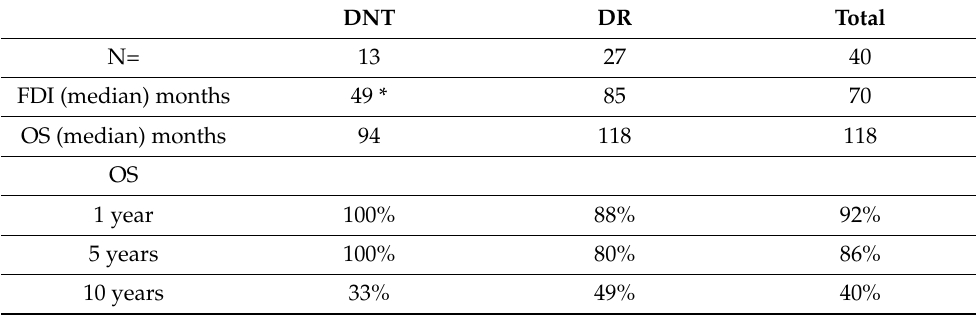
Table 3. Oncologic outcomes, DFI, and OS.